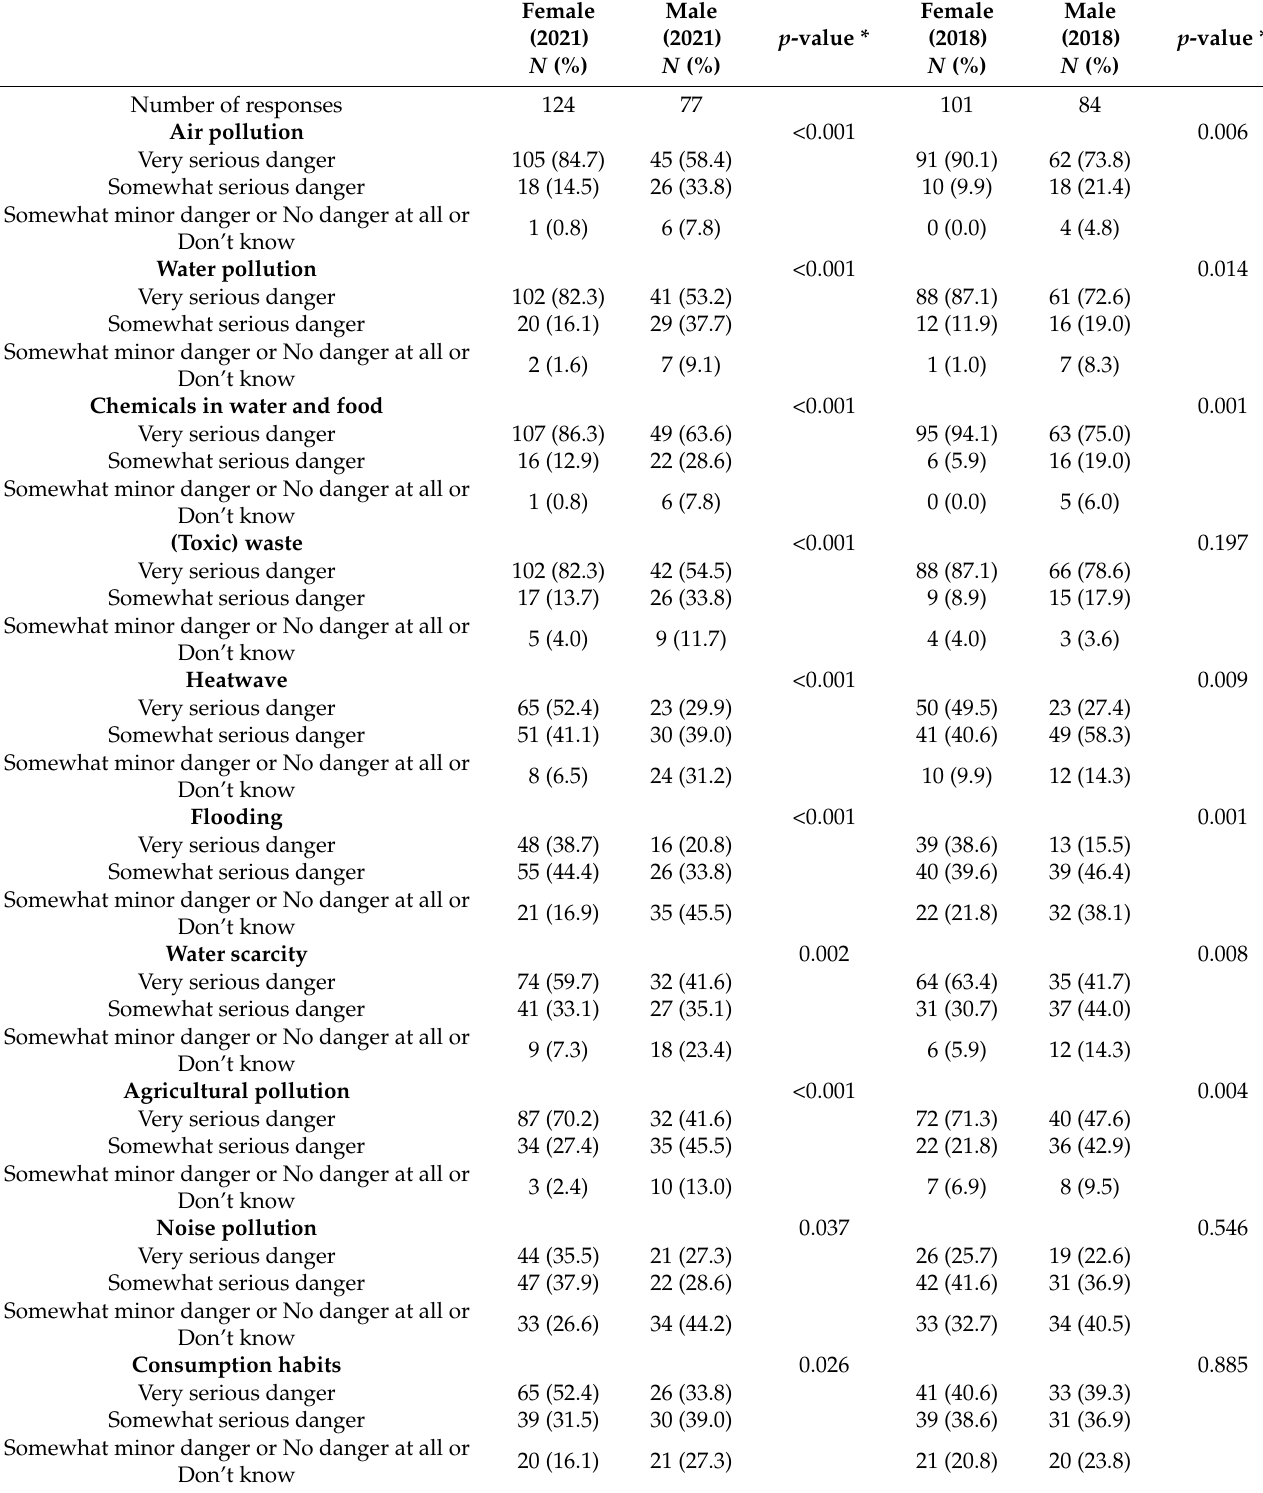
Table 5. Perceived danger level of environmental factors for health, by sex, to the 2018 and 2021 survey question: “How dangerous do you think the following environmental exposures are